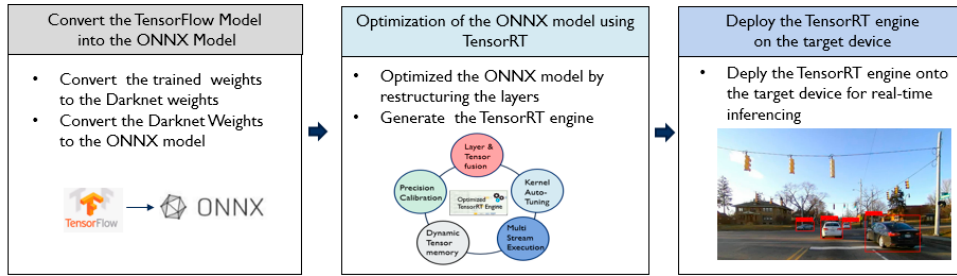
( b ) Figure 7. Network graph compression to optimize the DNN model: ( a ) the network graph before optimization; ( b ) the network graph after the model compression.